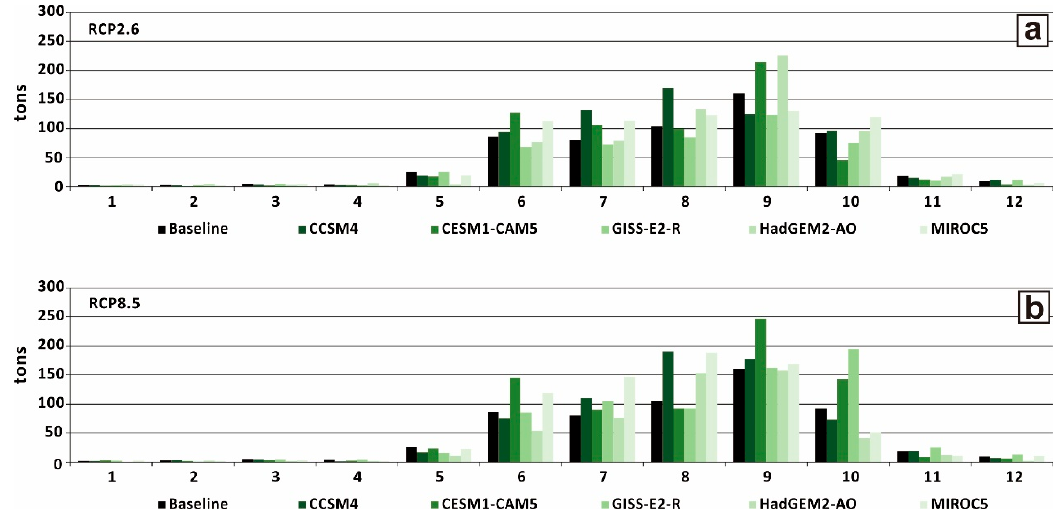
Figure 5. The average monthly sediment export under climate change scenarios ( a ) RCP2.6 and ( b ) RCP8.5. Note: Numbered months along x-axis.